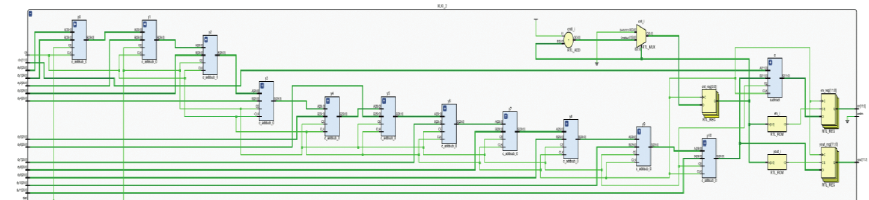
Figure 13: Integrated circuit diagram of the error calculation module.